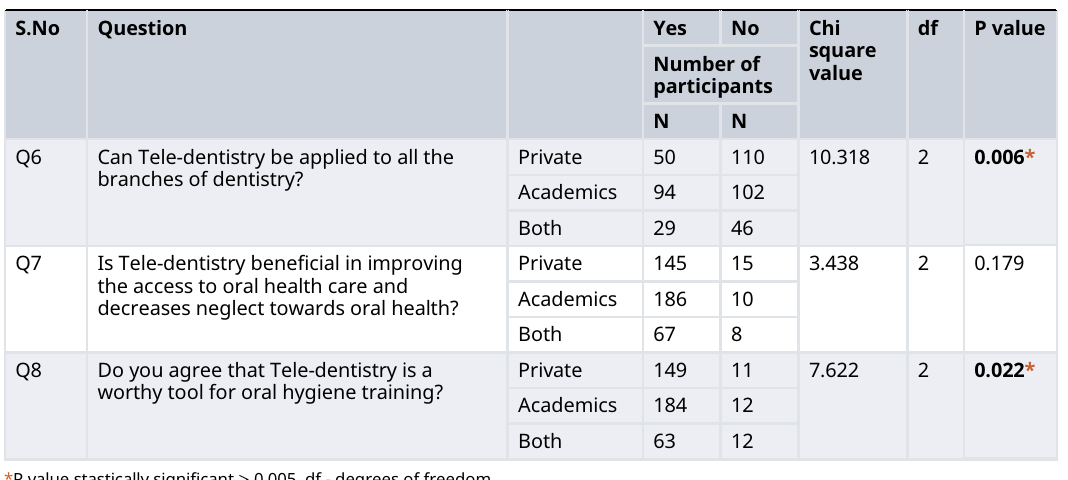
Table 4. Logistic regression analysis qualification as dependent variable and knowledge of teledentistry as independent variable. B S.E. Wald df Sig. Exp(B) 95% C.I.for EXP(B) Step 1 a Lower